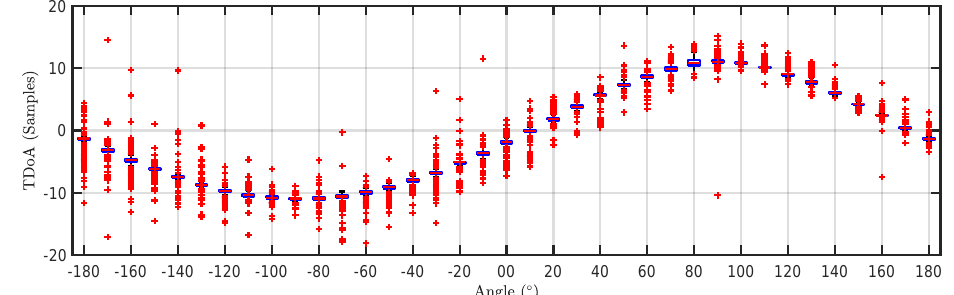
Figure 9. Box plot of the time differences of arrival versus angle of rotation for the pulses generated by source 1 (black